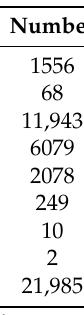
Table 5. Statistical table of SSR analysis results.